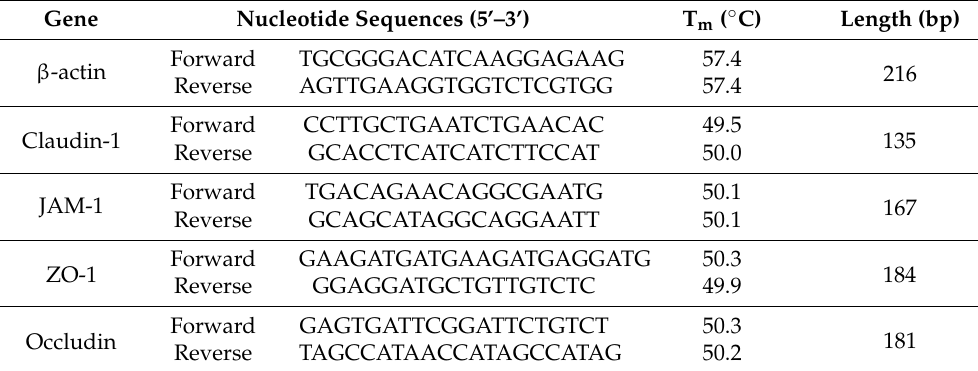
Table 1. Primer sequences for Q-RT